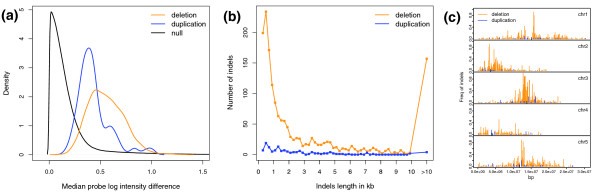
The deletions (orange) and duplications (blue) detected in Van. (a) The density distribution of median probe log intensity difference between Col and Van for deletions, duplications, and all analyzed probes (black). For each probe the absolute difference of mean probe log intensity between four Col replicates and four Van replicates was calculated. The medians were then obtained across deleted or duplicated regions. (b) The length distribution of deleted and duplicated regions. (c) The chromosome distribution of deleted and duplicated regions. Each chromosome was divided into 100 kb bins. Within each bin the length of deletions or duplications was divided by the bin size (y-axis). The black ticks along each chromosome mark the position of centromeres.